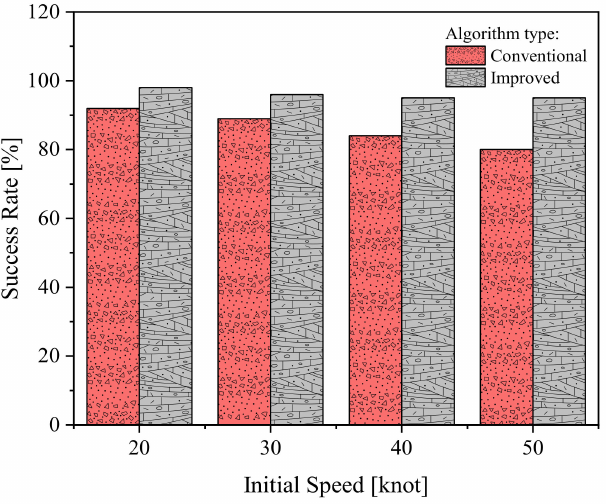
Figure 36. Influences of the deployed GA types on the success rate